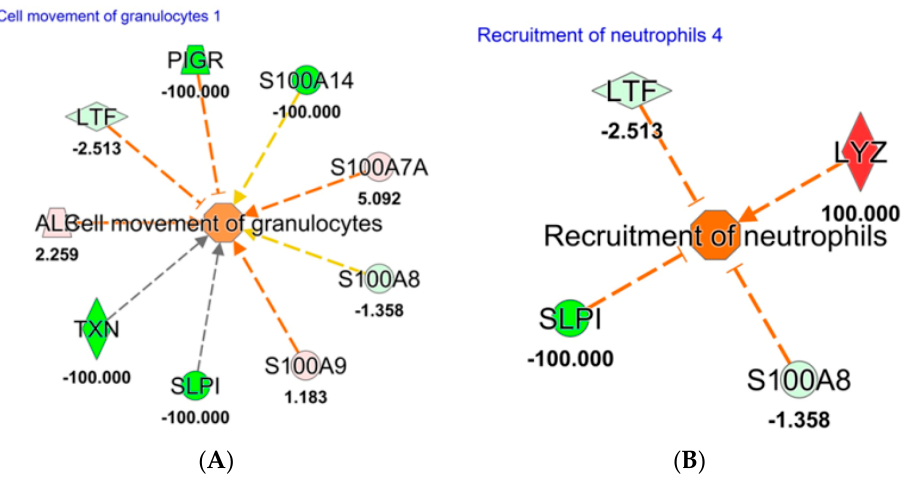
Figure 4. Downstream analysis, using Ingenuity Pathway software, based on proteins identified and quantified in EVs sorted in POAG and CTRL tears. Red and green color indicates genes significantly increased and decreased in expression, respectively, while the number represent the fold change log. The dotted lines represent indirect relationships. Symbols used in the figure represent: Vertical rhombus, enzyme; trapezoid, transporter; circle, other; concentric circles, complex/group. ( A ): Cell movement of Granulocytes; ( B ): Recruitment of Neutrophils. Abbreviation: Polymeric immunoglobulin receptor ( PIGR ); Antileukoproteinase ( SLPI ); Thioredoxin ( TXN ); Albumin ( ALB ); Lactotransferrin ( LTF ); and Lysozyme C ( LYZ ).